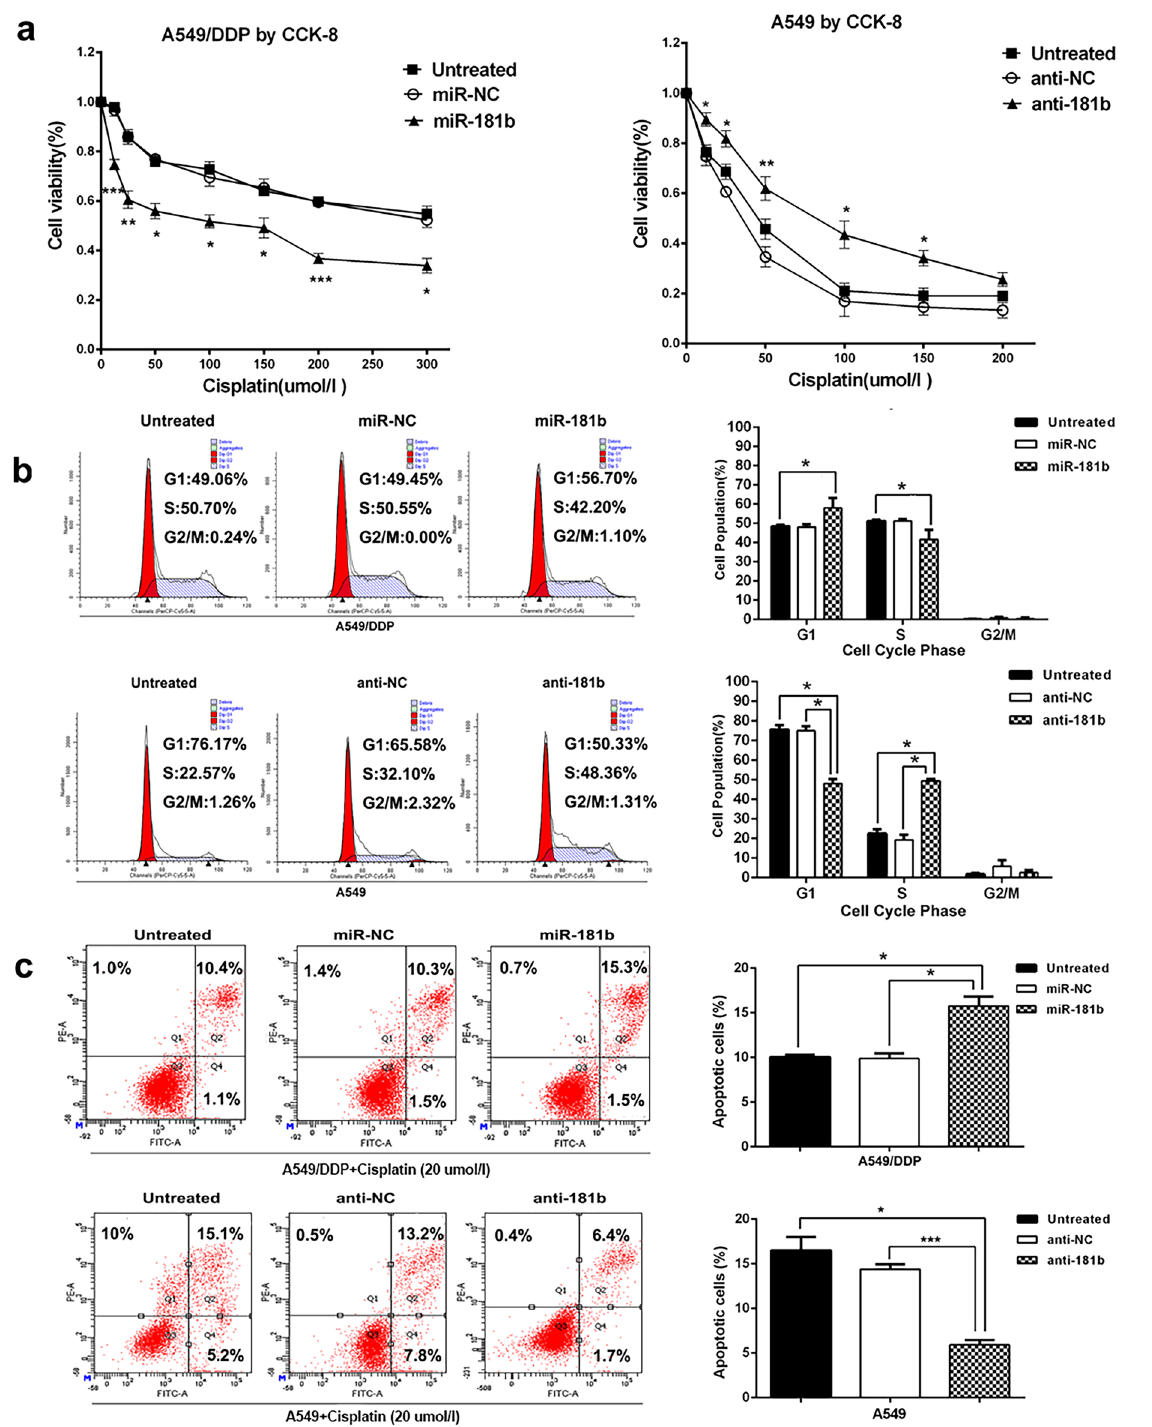
Figure 2. MiR-181b enhances chemosensitivity of NSCLC cells to DDP. ( a ) CCK analysis of IC50 values of DDP after transfected with miR-181b mimics, miR-181b inhibitors, or control in A549/DDP or A549 cell lines. ( b ) Flow cytometric analysis of cell cycle in A549/DDP and A549 were determined after transfected miR-181b mimics, miR-controls, miR-181b inhibitors or negative controls combined with DDP. ( c ) Flow cytometric analysis of apoptosis in A549/DDP and A549 were determined after transfected miR-181b mimics, miR controls, miR-181b inhibitors or negative controls combined with DDP. * P < 0.05; ** P < 0.01; *** P <